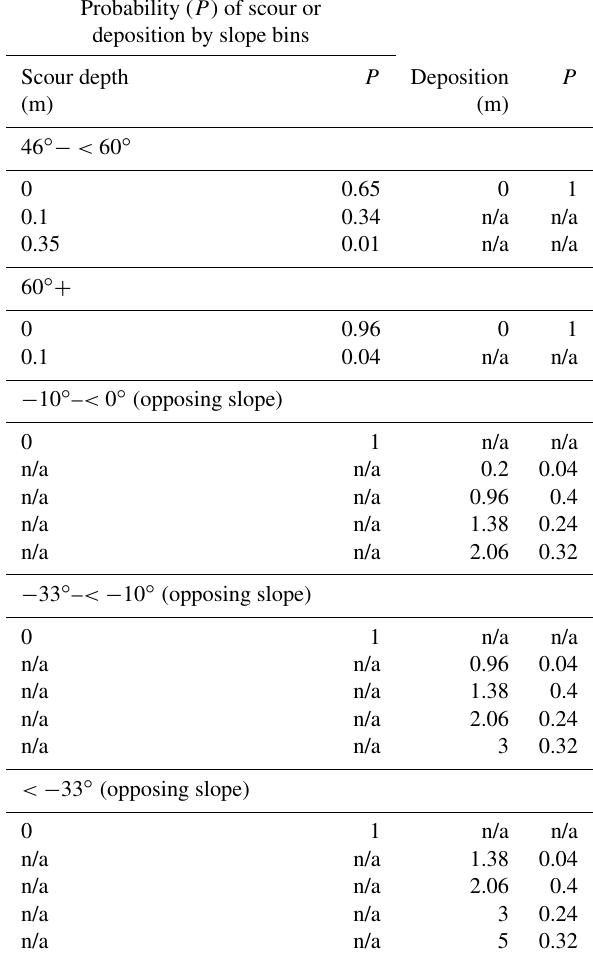
Table 1. Basic scour and deposition rules used in DebrisFlow Pre- dictor. Data come from Wise (1997) and Guthrie et al. (2008,